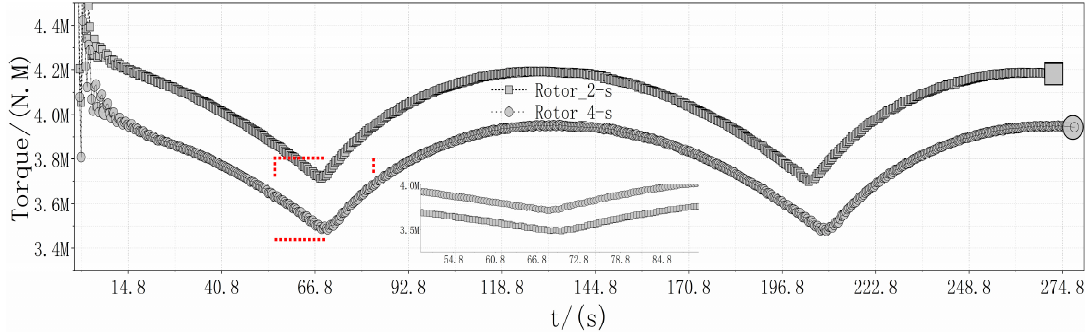
Figure 15. Torque characteristics of rotor under two different yawing rotational velocities.